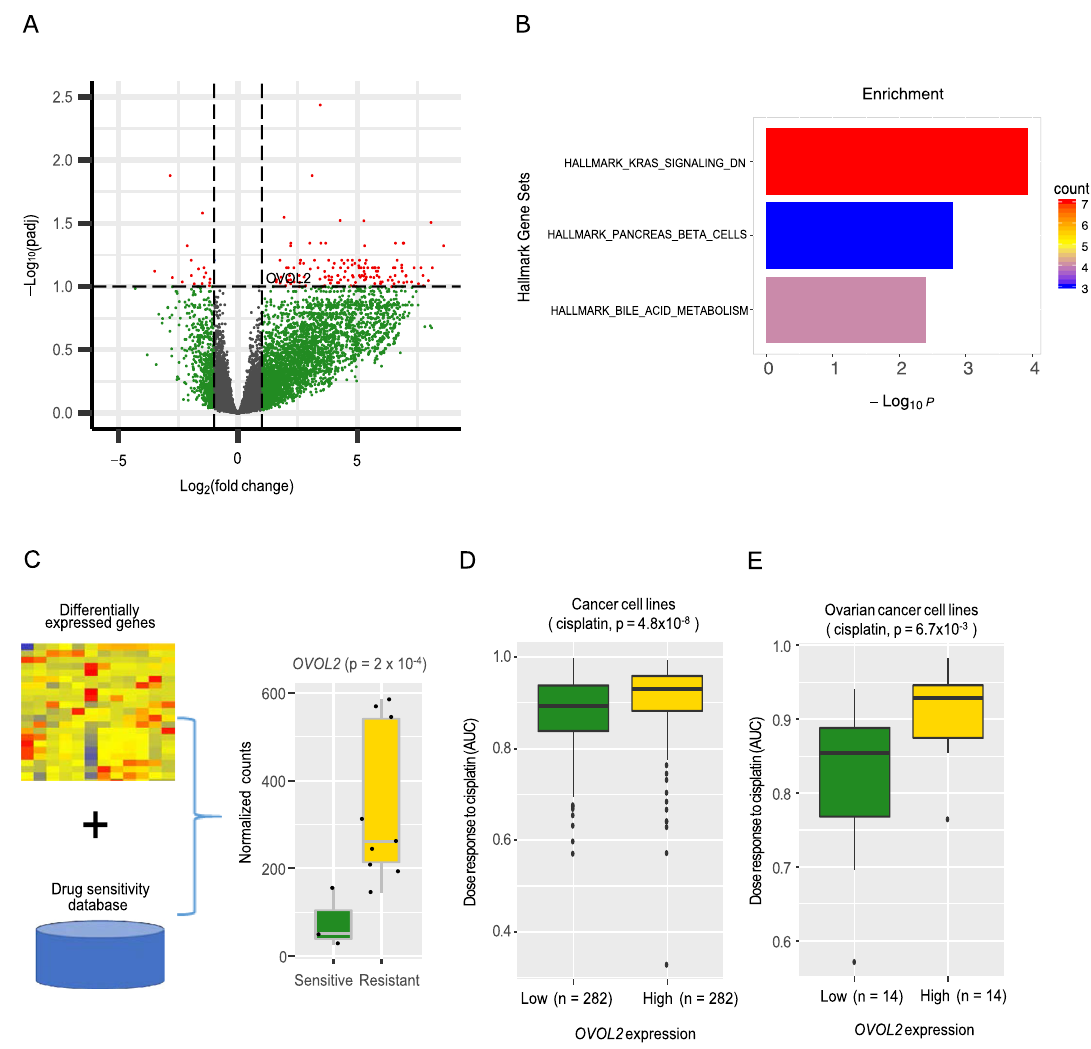
Fig. 6 Differentially expressed genes between chemo-sensitive primary and relapsed YST samples. A A volcano plot showing genes differentially expressed in primary and relapsed YST samples (fold-change >2, FDR <0.1). B Enrichment of differential genes in cancer hallmark pathways. C Correlation analysis of drug sensitivity and expression level identi fi es OVOL2 as a top candidate. The left panel show normalized count numbers from sensitive ( n = 3 biologically independent samples) and resistant ( n = 9) groups. The p value was computed by DEseq2. D The expression levels of OVOL2 in cancer cell lines with different responses to cisplatin (two-sided Wilcoxon rank sum test, p = 4.8 × 10 − 8 ; OVOL2 expression low group: n = 282 biologically independent samples; OVOL2 expression high group: n = 282). E The expression levels of OVOL2 in ovarian cancer cell lines with different responses to cisplatin (two-sided Wilcoxon rank sum test, p = 6.7 × 10 − 3 ; OVOL2 expression low group: n = 14; OVOL2 expression high group: n = 14). C – E The middle line in the box is the median, the bottom and top of the box are the fi rst and third quartiles, and the whiskers extend to 1.5× interquartile range of the lower and the upper quartiles,